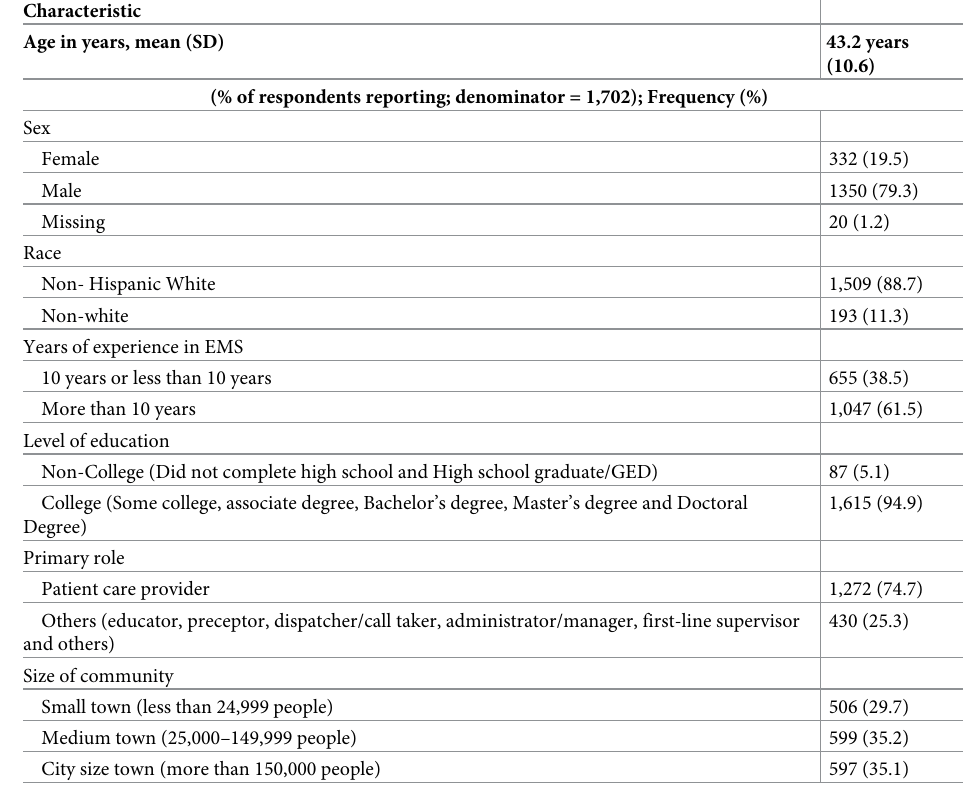
Table 2. Characteristics of